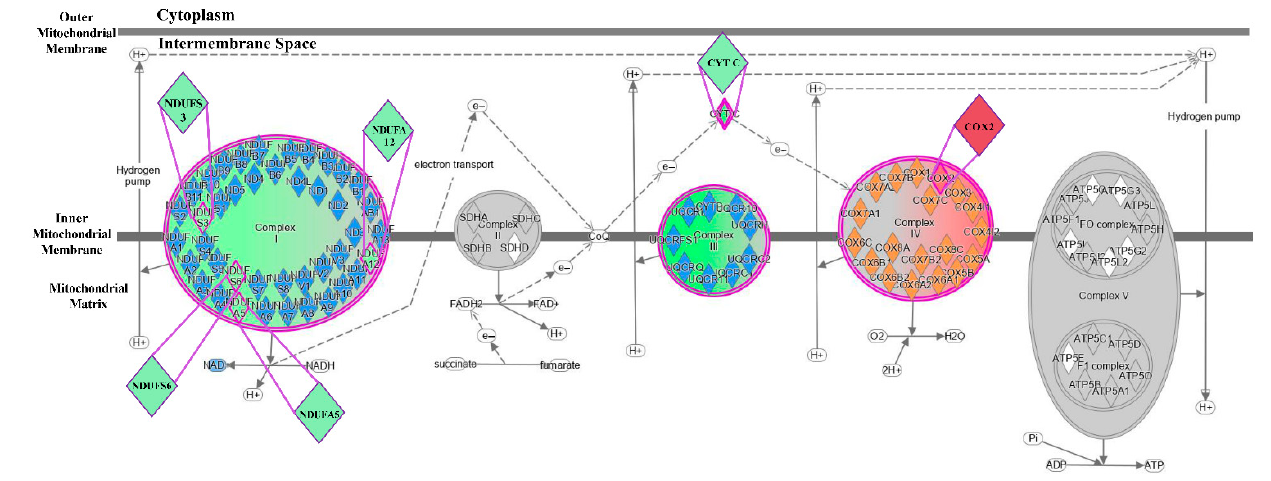
Figure 6. The differences between the HFD and the HFr/HFD groups in pathway and protein expression associated with the respiratory chain in liver, analyzed using the Ingenuity Pathway Analysis. Purple denotes pathways that are upregulated in the HFr/HFD group, compared with the HFD group. Green indicates pathway and protein downregulation in the HFr/HFD group, compared with the HFD group. Red indicates pathway and protein upregulation in the HFr/HFD group, compared with the HFD group. A gray background indicates pathway and protein unaffected. HFD: high-fat diet group. HFr/HFD: high-fat diet plus 30% fructose in drinking water group.